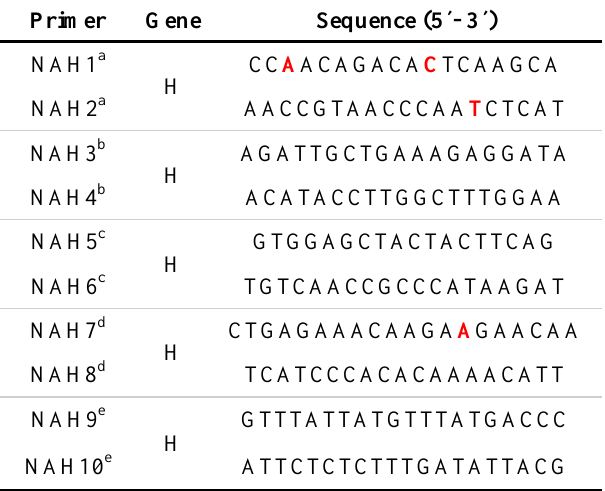
Table 1: Oligonucleotide primers designed from the H gene of the CDV virus for RT-PCR reaction described by Negrão and collaborators (Negrão et al., 2013) . In red, the nucleotides modified in our study: